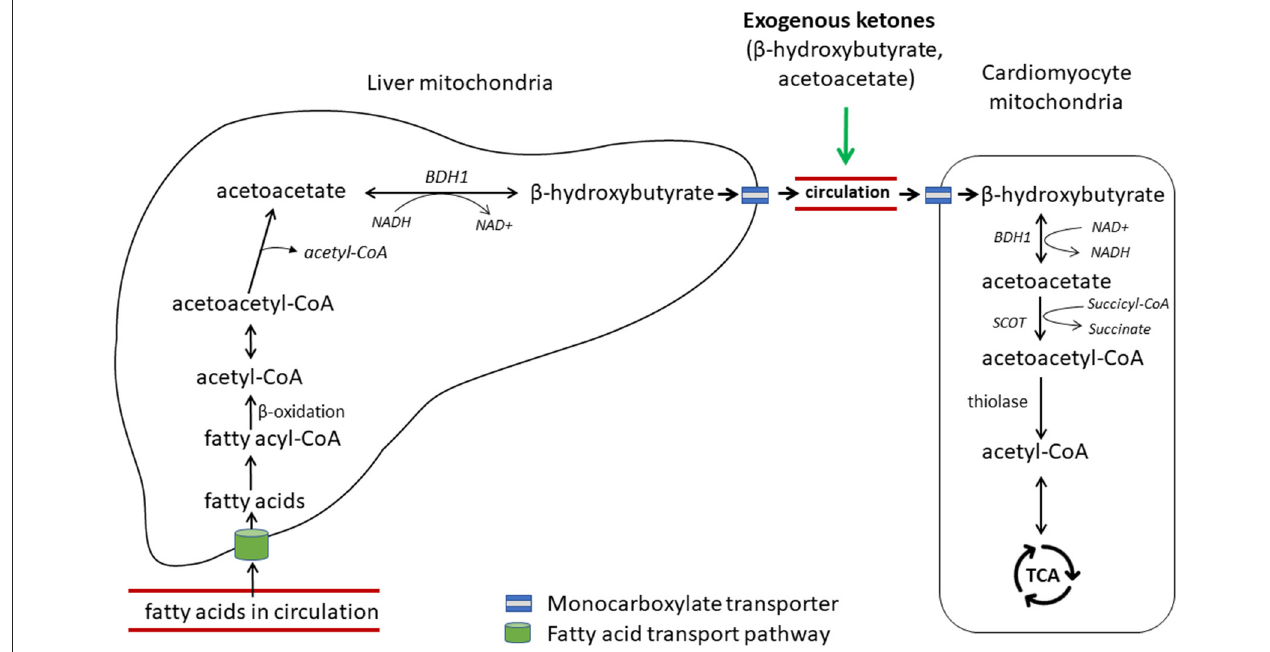
FIGURE 4 | Hepatic ketogenesis and cardiac ketolysis. Free fatty acids in circulation are transported into the liver via a carrier protein-assisted transport pathway. These fatty acids undergo fatty acid oxidation in the hepatic mitochondria to produce acetyl-CoA, which after a series of enzymatic reactions produces ketone bodies, acetoacetate and β -hydroxybutyrate. Ketones are transported to the heart and other extrahepatic organs via blood portal by the monocarboxylate transporters 1 and 1 (MCT1/2). β -hydroxybutyrate is converted to acetoacetate by β -hydroxybutyrate dehydrogenase 1 (BDH1), one of the key enzymes for ketone utilization. Acetoacetate is activated to acetoacetyl-CoA by succinyl-CoA:3 ketoacid-CoA transferase (SCOT), the rate-limiting enzyme for ketolysis. Acetoacetyl-CoA undergoes a final thiolysis reaction to be separated into 2 molecules of acetyl-CoA. Adapted from Selvaraj et al. (